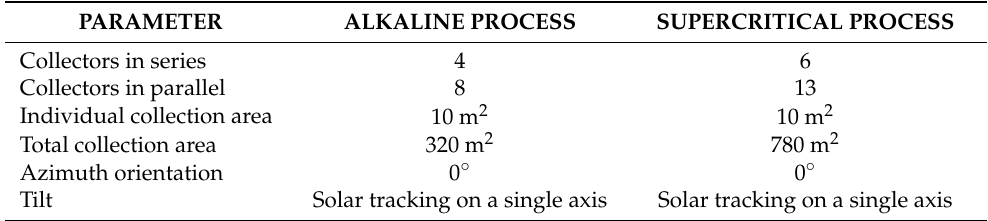
Table 5. Parameters of the array of parabolic trough collectors for each process. PARAMETER ALKALINE PROCESS